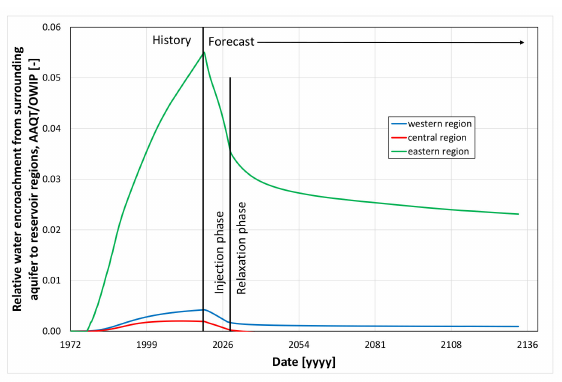
Figure 37. Average reservoir pressure.